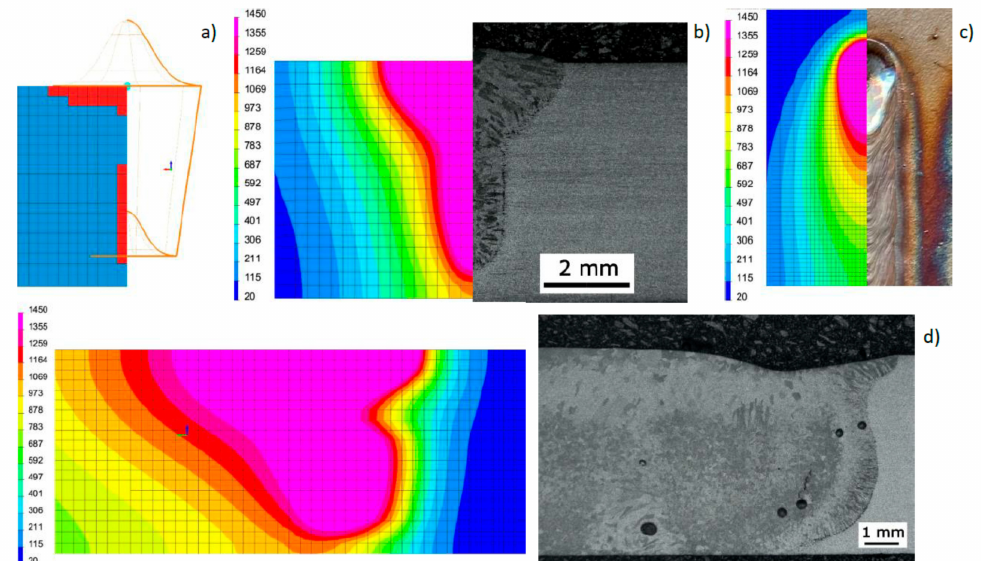
Figure 13. View ( a ) of the method of loading the mesh elements and placement of the conical model of the heat source, comparing ( b ) the shape of the bead on the cross-section, ( c ) the shape and size of the weld pool, and ( d ) the longitudinal section of DL_T3 test bead with the results of numerical analyses (Tables 3 and